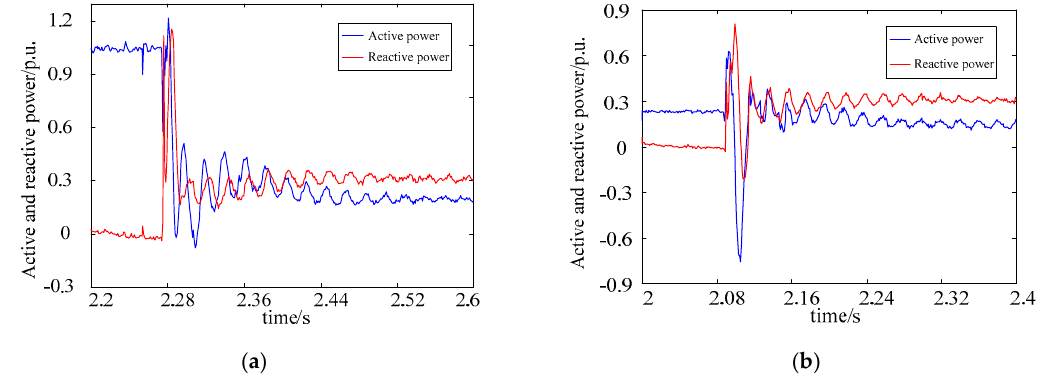
Figure 13. Active and reactive power under different conditions: ( a ) supersynchronous condition; ( b ) subsynchronous condition.